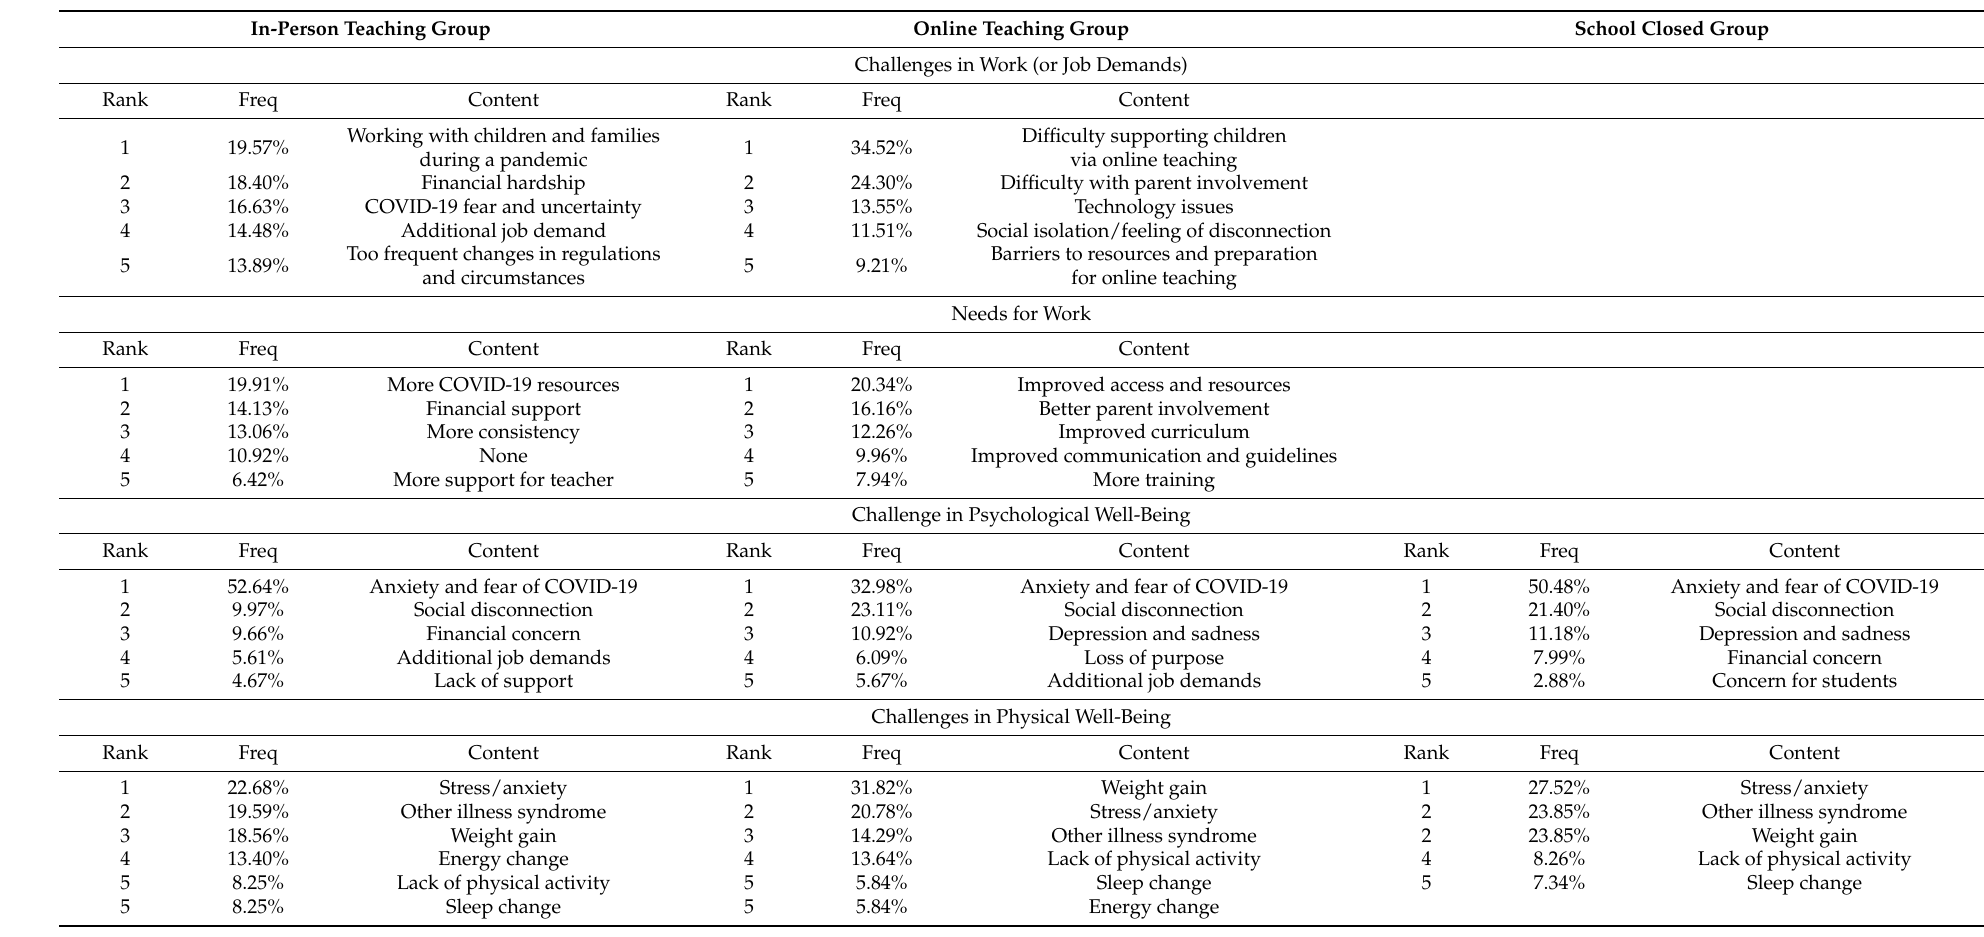
Table 3. Content analysis summary: challenges in work and